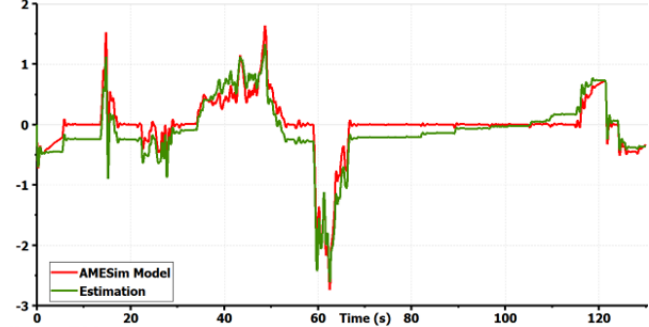
Figure 8. Validation of the vehicle model: vertical velocity of the sprung mass [10].